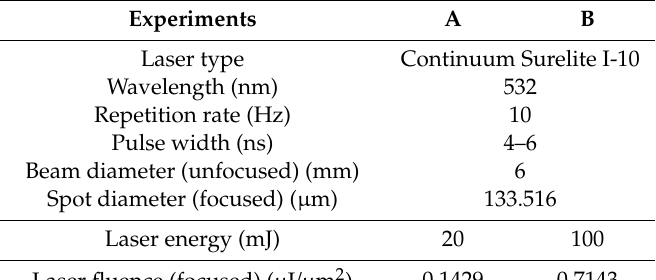
Table 2. Laser parameters of experiment.